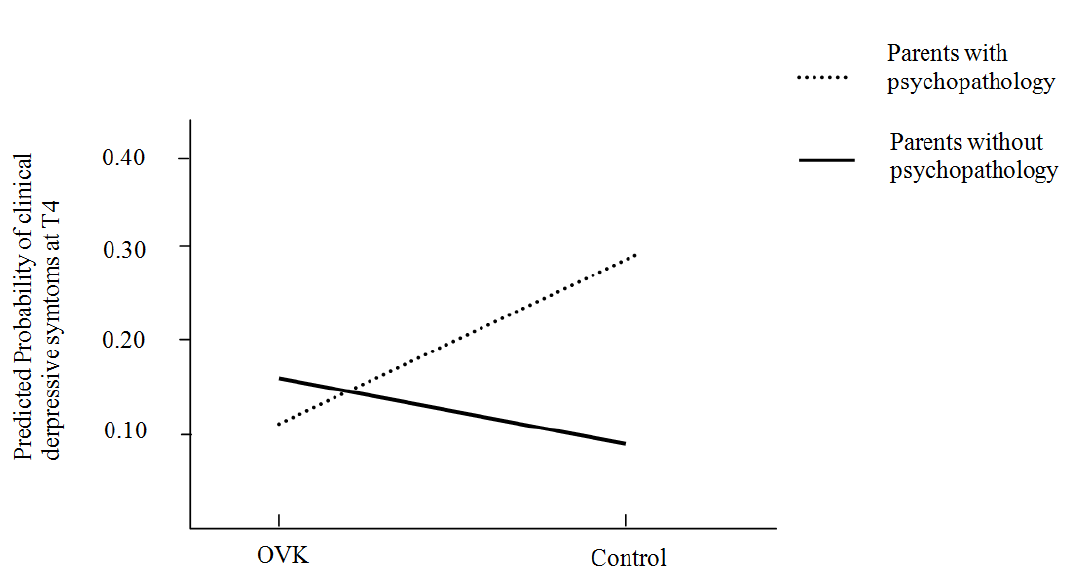
Figure 2. Interaction effect for adolescents with/without parents with psychopathology and the